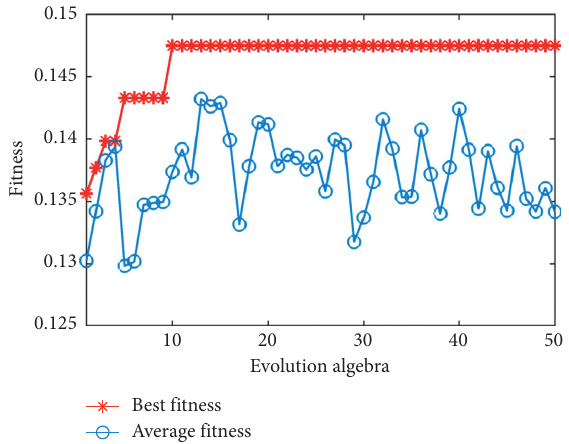
Figure 5: The trend of local characteristic order amplitude with evolution algebra. Table 1: Parameters setting and optimization results of PSO. Parameters